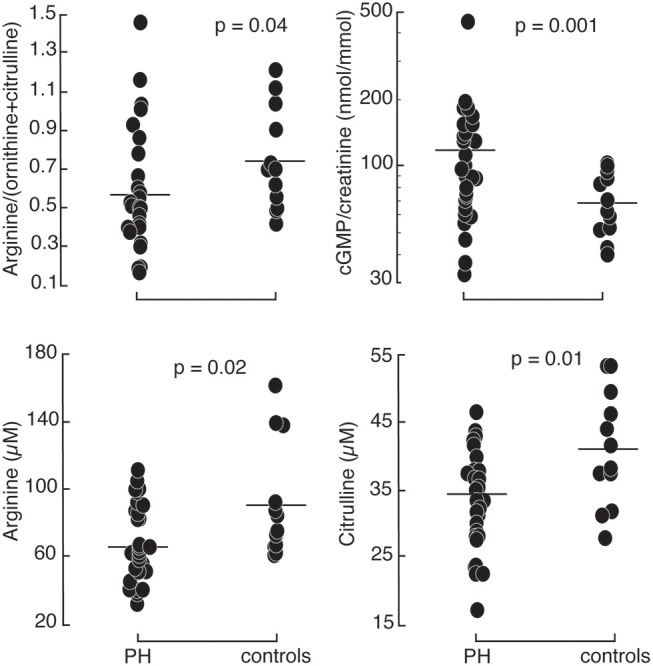
Comparison between healthy controls (N = 12) and PH subjects (N = 30): PH patients had higher urinary cyclic guanosine monophosphate normalized by creatinine (cGMP/creatinine). They had lower arginine, citrulline, and global arginine bioavailability compared to healthy controls.